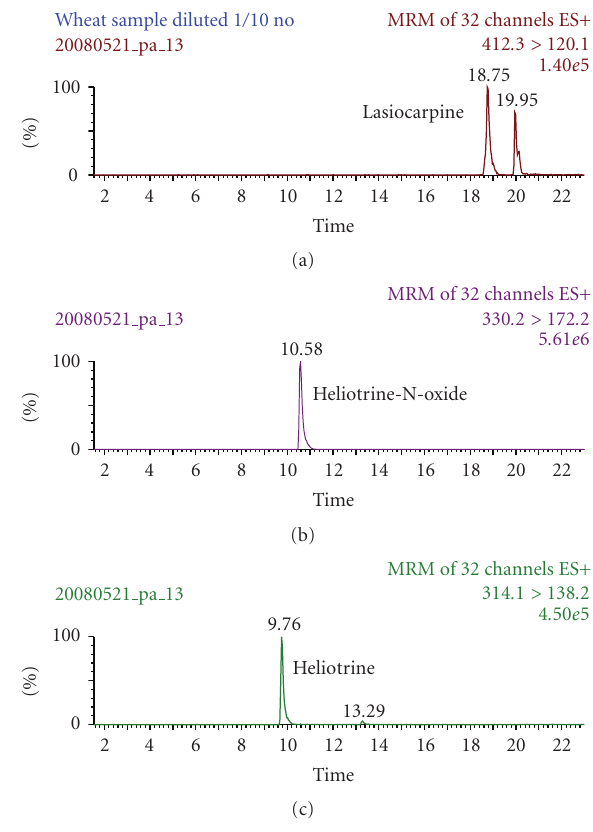
Figure 1: Chromatogram of wheat sample from a suspected area. The traces (mother > daughter ions) shown are those from the strongest transition of the two traces acquired for each